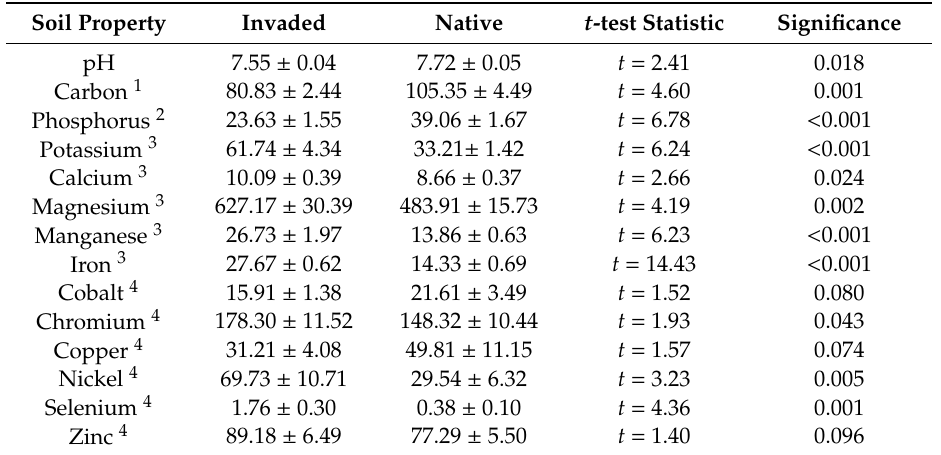
Table 2. The chemical properties of Guam cobbly clay soils within invaded mature stands of. Leucaena leucocephala and in adjacent native forest in central Guam. Means ± SE, n =